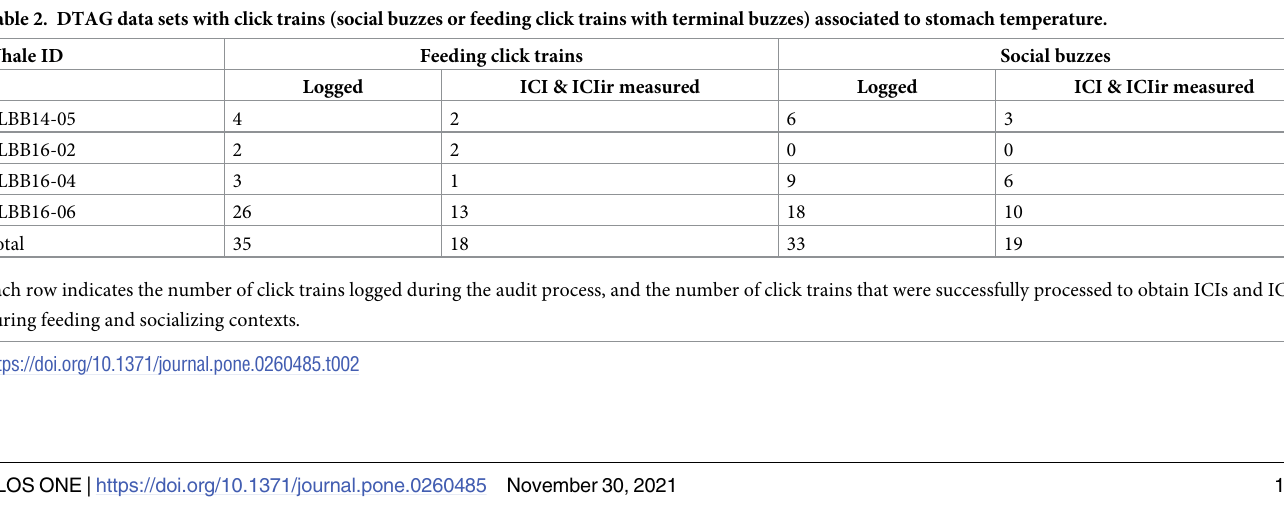
Table 2. DTAG data sets with click trains (social buzzes or feeding click trains with terminal buzzes) associated to stomach temperature. Whale ID Feeding click trains Social buzzes Logged ICI & ICIir measured Logged ICI & ICIir measured